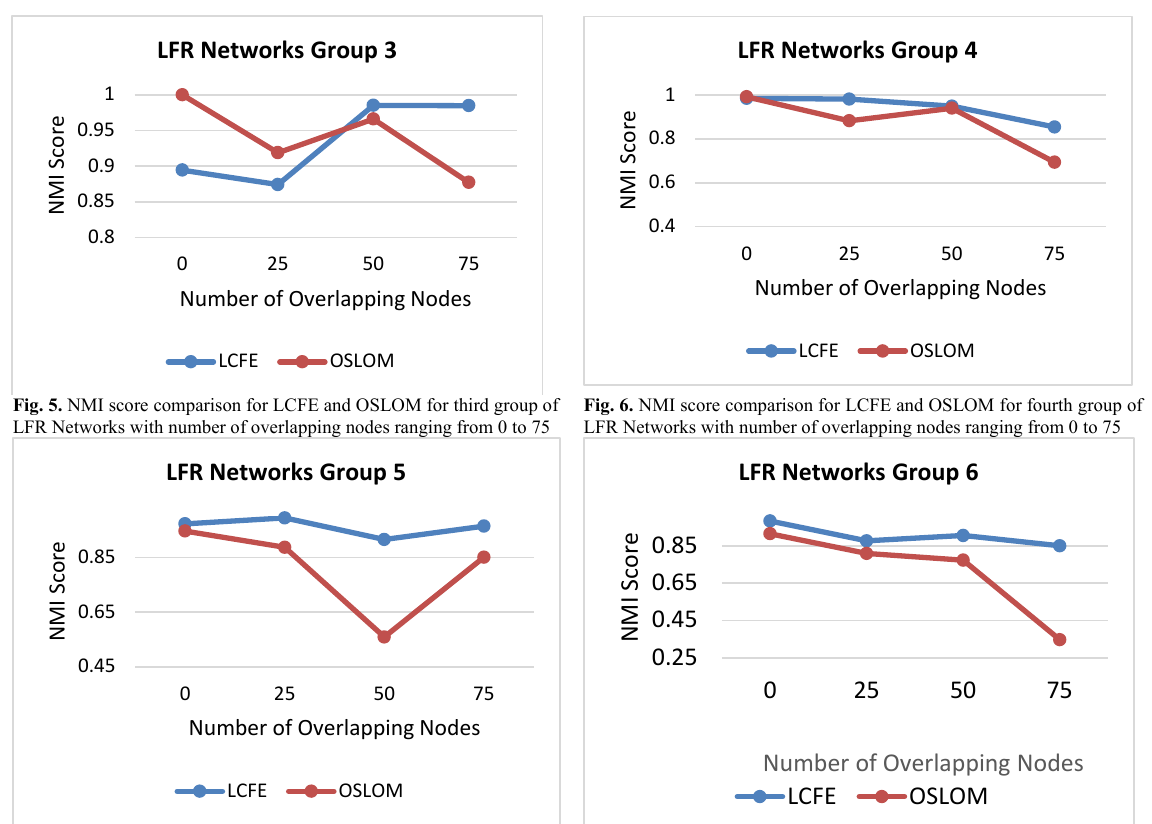
Fig. 7. NMI score comparison for LCFE and OSLOM for fifth group of LFR Networks with number of overlapping nodes ranging from 0 to 75